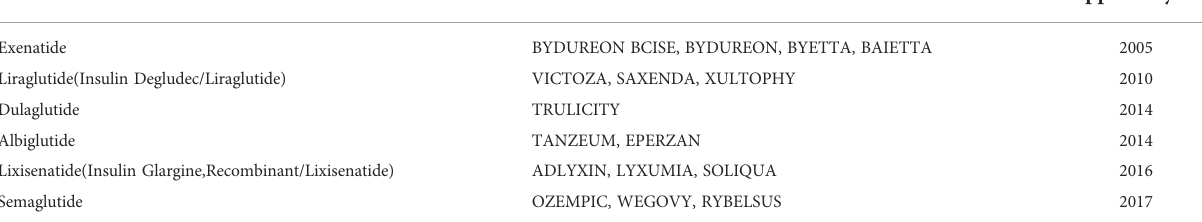
TABLE 1 Information summary of GLP-1 receptor